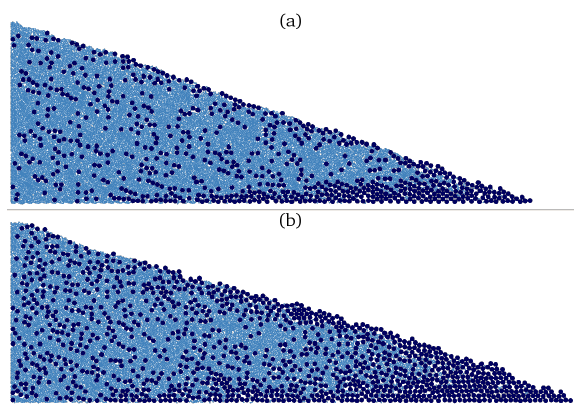
Figure 2. Heaps patterns as results of 2D simulations; (a) mass ratio m LS = 0 . 5, size ratio is 3:1, f = 0 . 1 g/ s and h = 10mm; (b)